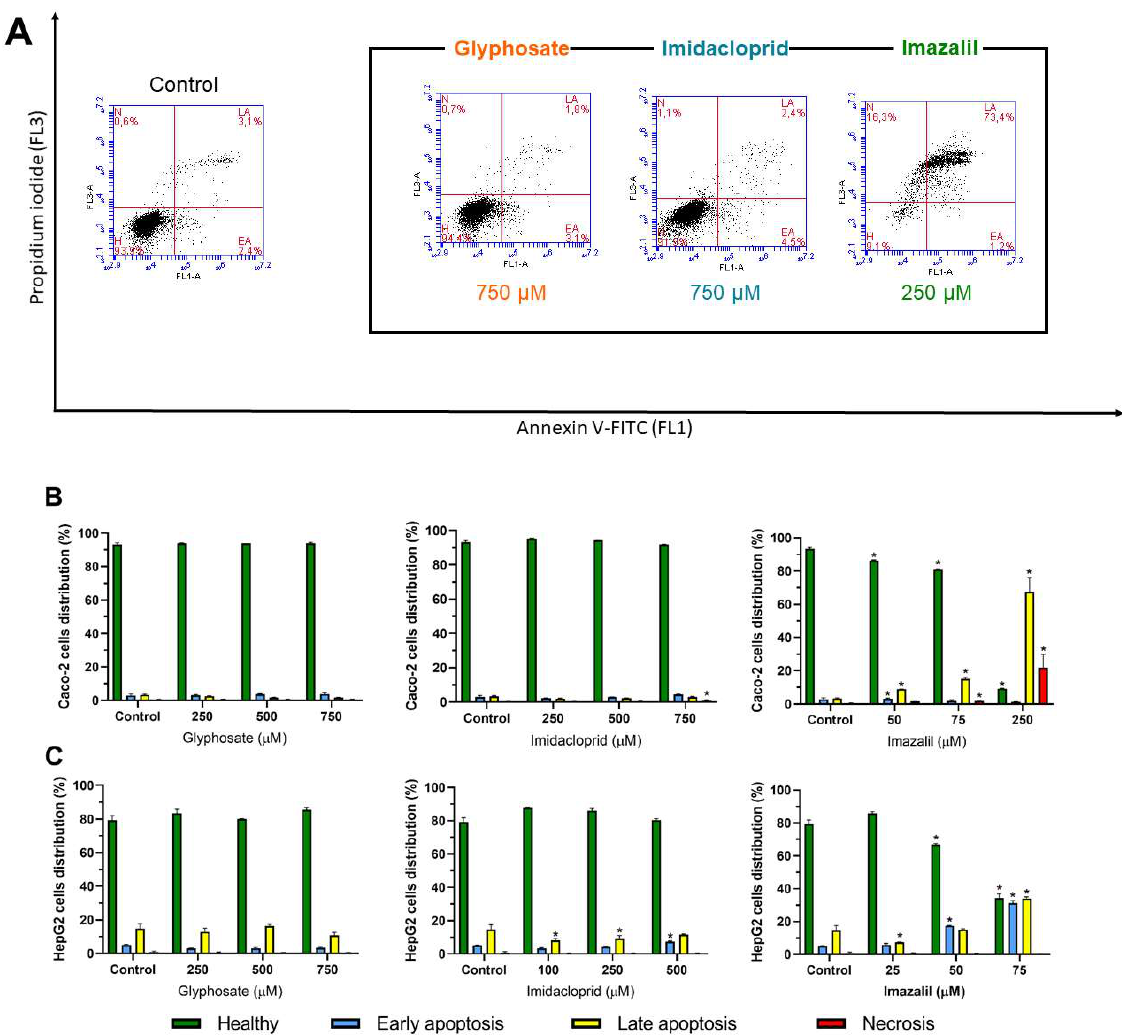
Figure 6. Evaluation of pesticide-induced apoptosis/necrosis in Caco-2 and HepG2 exposed to GLY, IMD and IMZ, for 24 h. ( A ): Representative flow cytometry scatter plots obtained from double- stained Caco-2 cells exposed for 24 h to the highest concentration of each pesticide (as denoted). ( B ) and ( C ): Graphical representation of Caco-2 ( B ) and HepG2 ( C ) cells distribution by the 4 main populations (H, healthy; EA, early apoptosis; LA, late apoptosis; N, necrosis). Results were obtained after analysis of dot plots as represented in A. Results are presented as mean ± SD ( n = 3). Significant statistical differences between the control and samples are denoted as “*” when p < 0.05.